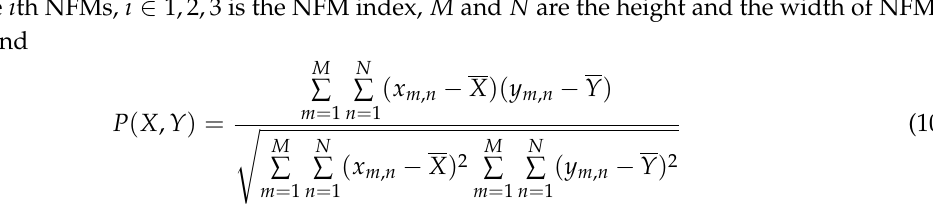
Figure 2. 3D scatter plots between AGGD parameters α , σ 2 three NFMs, where each point in the scatter plots represent one distorted image in LIVE [28] database: ( a ) scatter plots for the first NFM; ( b ) scatter plots for the second NFM; and ( c ) scatter plots for the third